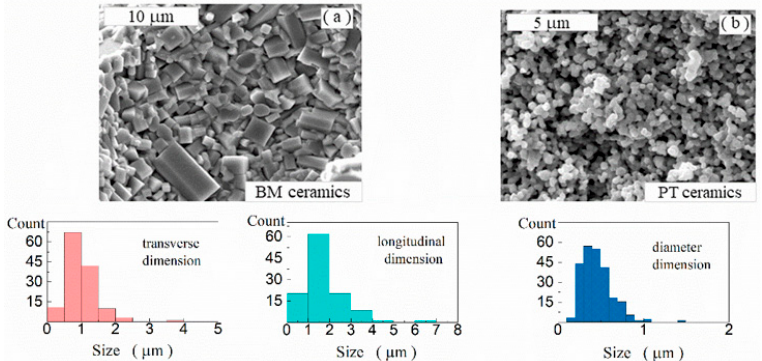
Figure 1. Secondary electron images obtained for BM ceramics ( a ) and PT ceramics ( b ). Histograms show grains’ transverse, longitudinal, and diameter size distribution.